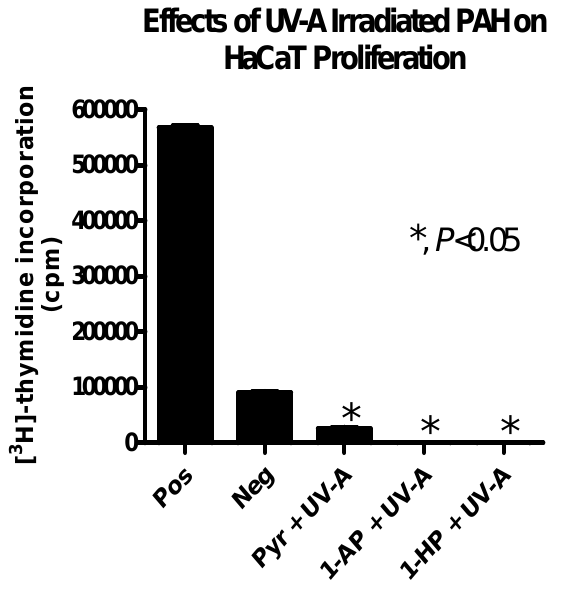
Figure 5: Effects of UV-A irradiated pyrene, 1- aminopyrene and 1-hydroxypyrene on HaCaT proliferation. HaCaT cells were grown in 35mm plates to sub-confluent in CGM. Cells were serum starved